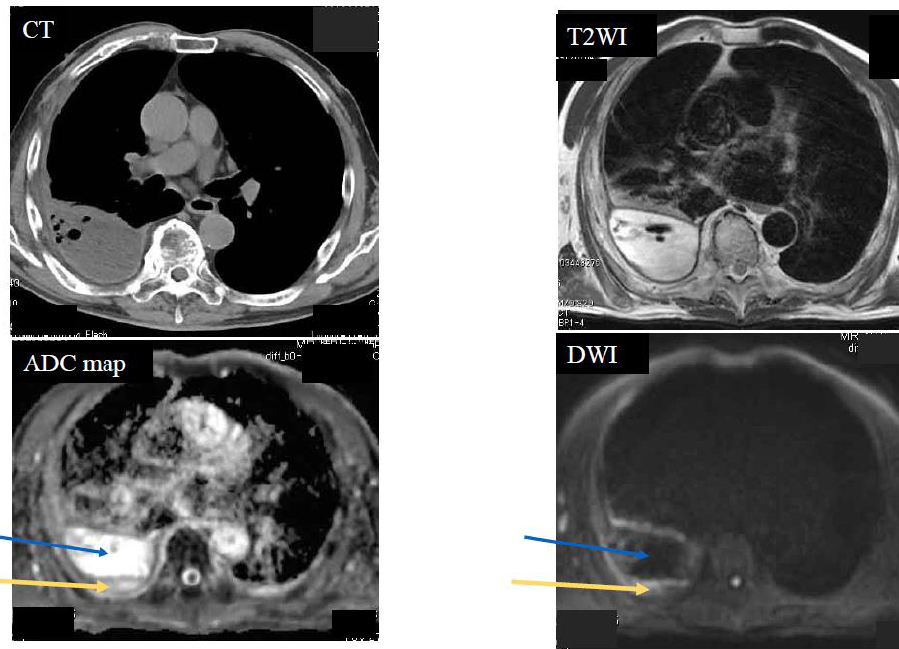
Figure 3. Case 3 — Empyema. A 70-year-old male with right empyema. The yellow arrows indicate pleural thickness. The blue arrows indicate pleural fluid. The apparent diffusion coefficient (ADC) of the pleural thickness was 1.82 × 10 − 3 mm 2 / s (negative) and the ADC of the pleural fluid was 3.95 × 10 − 3 mm 2 / s